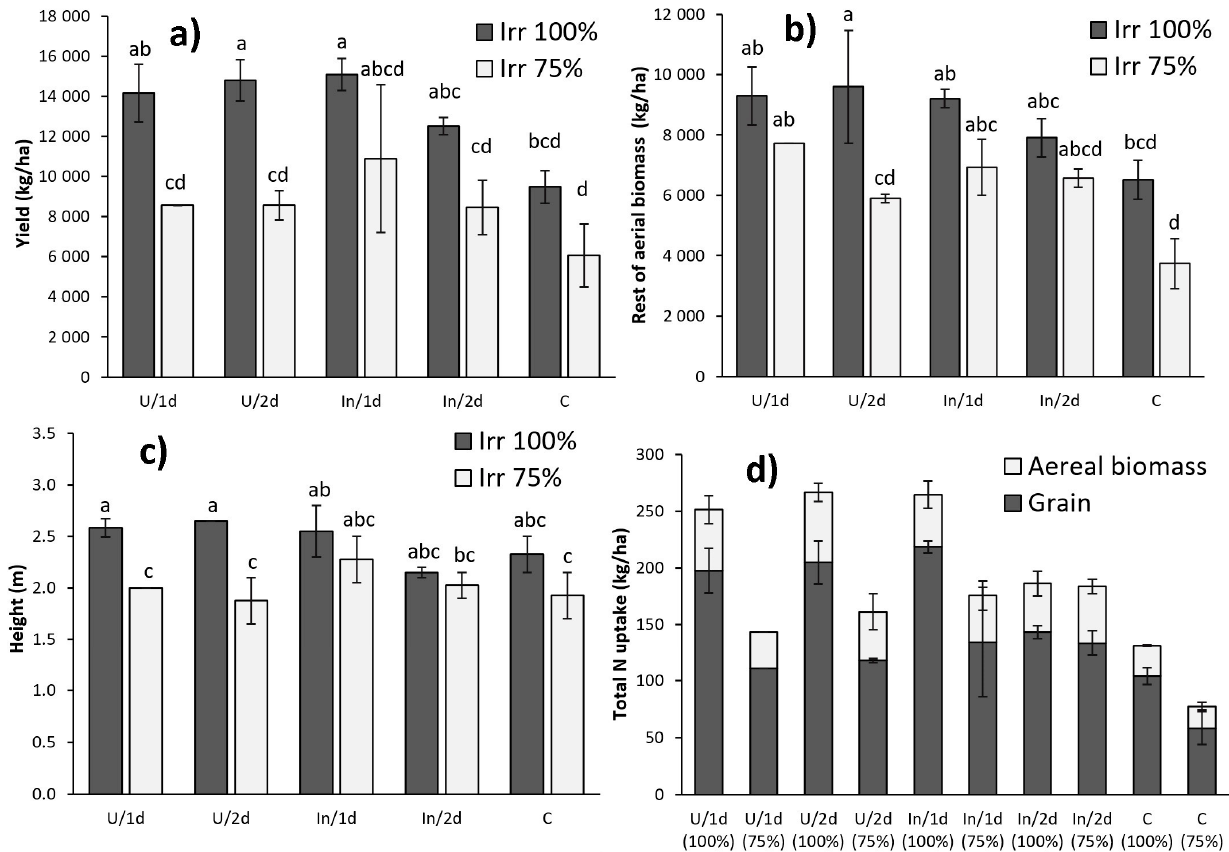
Figure 2. ( a ) Maize grain yield (dry matter), ( b ) aerial biomass (dry matter), ( c ) height and ( d ) N uptake for the different fertilization and irrigation treatments. Letters indicate statistical differences between treatments ( p < 0.05). Treatments were a combination of urease inhibitor use (In), simple urea use (U), or no fertilizer (C), with fertilizer application in one (1 d) or two (2 d) dressings and optimally irrigated (100%) or sub-optimally irrigated (75%).